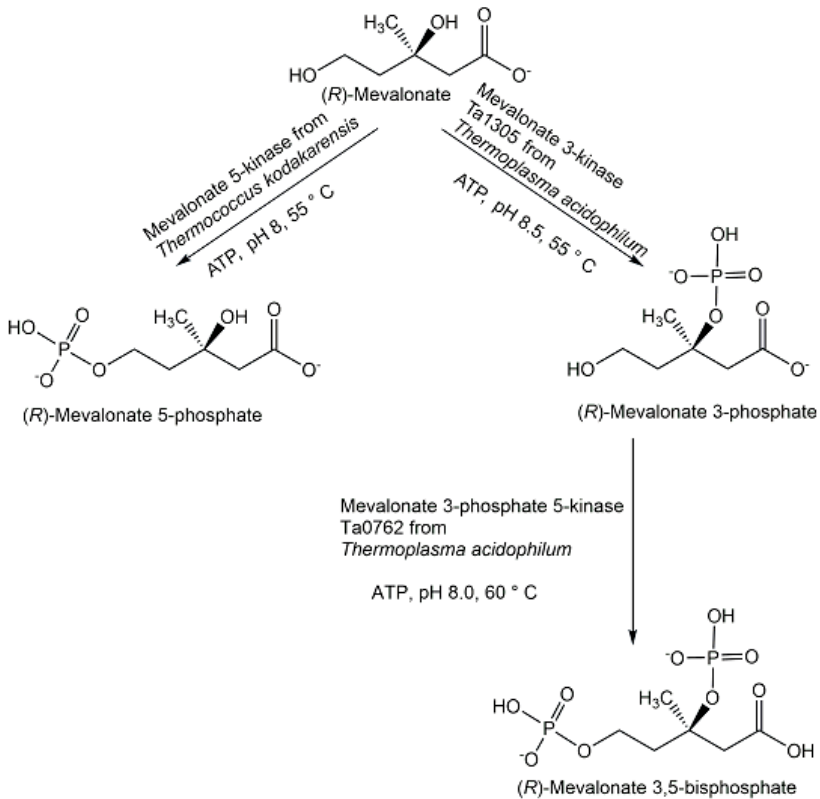
Figure 18. Enzymatic synthesis of phosphorylated chiral mevalonates. ( R )-mevalonate 3-phosphate was synthesized from ( R )-mevalonate by phosphoryla- tion catalyzed by mevalonate 3-kinase Ta1305 [94,122]. ( R )-mevalonate 3,5-bisphosphate has been prepared from ( R )-mevalonate by a first phosphorylation catalyzed by meval- onate 3-kinase Ta1305, followed by a second phosphorylation catalyzed by mevalonate 3-phosphate 5-kinase Ta0762 [123,124], or by the E140 mutants which convert the meval- onate 3-kinase into a mevalonate 3-phosphate 5-kinase by replacing a glutamate residue interacting with the substrate by smaller amino acids [124]. Shikimate-3-phosphate lithium salt was prepared with >97% purity and 53% yield by highly efficient and selective phospho- rylation of shikimate in one reaction step catalyzed by recombinant shikimate kinase AroL from E. coli [125,126]. Phosphorylated monosaccharide sugar acids represent an important family of biologically active phosphometabolites which play key roles in carbohydrate metabolism and illustrate also the higher molecular diversity of chiral phosphohydrox- ycarboxylic acids as the number of carbon atoms increases. Various approaches have been taken for the synthesis of phosphorylated monosaccharide sugar acids, such as the use of microbial whole cells, selective enzymatic phosphorylation of the corresponding monosaccharide sugar acid, or selective water elimination from phosphorylated monosac- charide sugar acids. This is exemplified with 2-keto-3-deoxy-6-phospho-D-gluconate, abbreviated KDPG, which was prepared from Alcaligenes eutrophus strain H16 F34 lack- ing KDPG-aldolase activity [127], from 2-keto-3-deoxy-D-gluconate by kinase-catalyzed phosphorylation [128,129], and through 6-phosphogluconate dehydratase-catalyzed water elimination from 6-phospho-D-gluconate